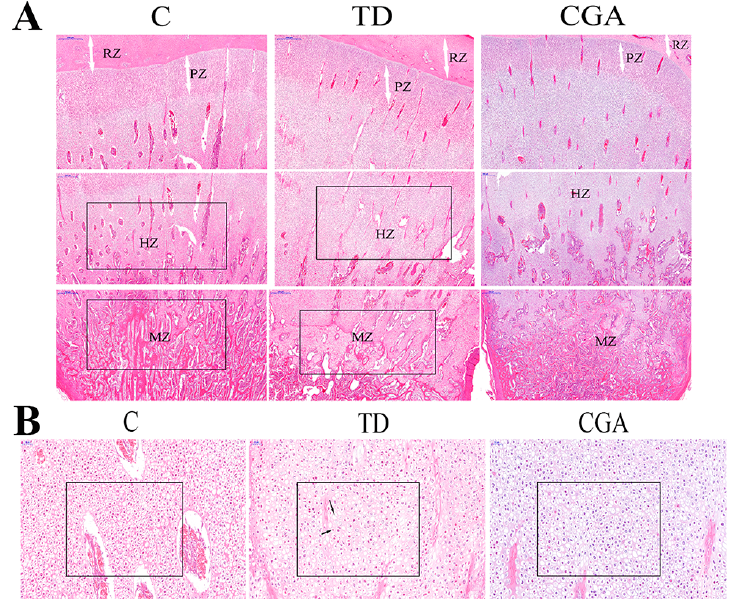
Figure 5. Histological examination of the tibia in broilers in three groups. C represents Control group, TD represents thiram-induced tibial dyschondroplasia group, CGA represents administration of chlorogenic acid after induction of TD. ( A ) H&E staining of tibiae containing resting zone (RZ), proliferating zone (PZ), hypertrophic zone (HZ) and mineralization zone (MZ). The scale bar is 500 µ m. ( B ) HE staining of hypertrophic zone in tibiae, the long arrow indicates dead cells without nuclei and the short arrow indicates red-stained-nuclei cells in TD. The scale bar is 50 µ